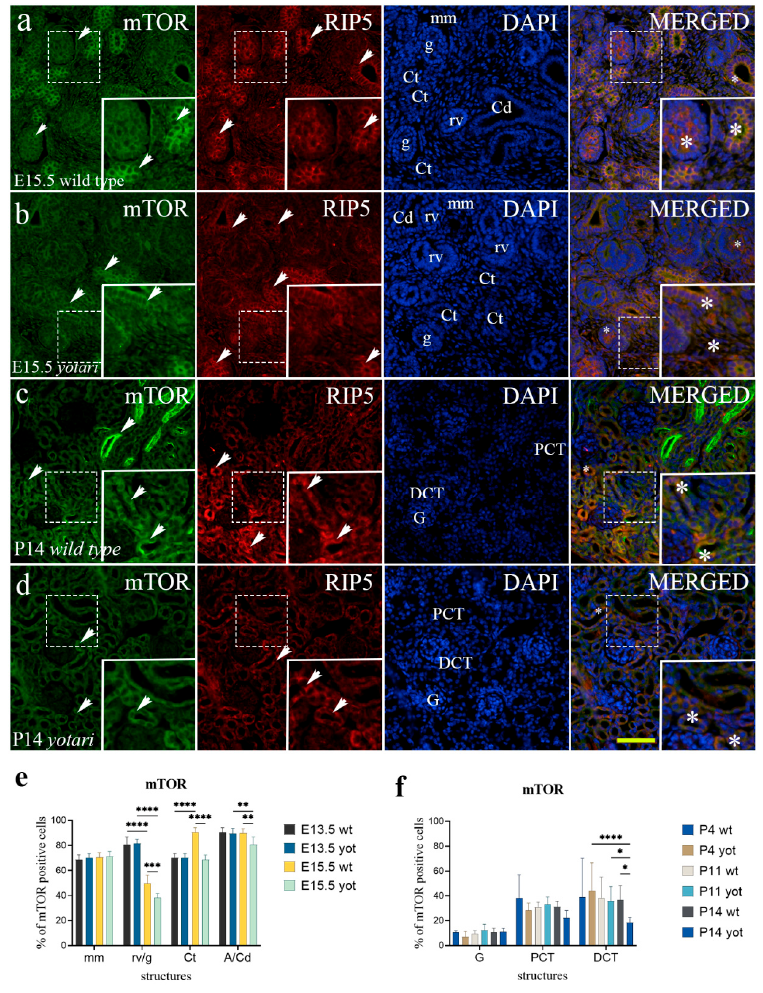
Figure 6. Double immunofluorescence staining of embryonic wild-type ( a ) and yotari ( b ) and postnatal wild-type ( c ) and yotari ( d ) mouse kidneys with the mTOR and RIP5 markers. Arrows show the expression pattern of mTOR and RIP5 in the mesenchyme (mm), renal vesicles (rv), immature glomeruli (g), convoluted tubules (Ct), ampullae (A), and collecting ducts (Cd), glomeruli (G), proximal convoluted tubules (PCT) and distal convoluted tubules (DCT) indicated on 4 ′ ,6-diamidino-2-phenylindole (DAPI) image. Immunoexpression of mTOR, RIP5, DAPI staining and merged mTOR, RIP5, and DAPI at embryonic day E15.5 in wild type ( a ) and yotari ( b ). Immunoexpression of mTOR, RIP5, DAPI staining and merged mTOR, RIP5, and DAPI at postnatal day 14 (P14) in wild type ( c ) and yotari ( d ). Wild-type and yotari mice at embryonic day E13.5 of kidney development mostly correspond regarding localization and intensity of mTOR; thus, a representative image was selected from E15.5. Wild-type and yotari mice at postnatal day 4 (P4) and 11 (P11) of kidney development mostly correspond regarding localization and intensity of mTOR; thus, a representative image was selected from P14. The most prominent protein expression area is shown in inserts, corresponding to the dashed boxes. An asterisk denotes the zone where co-